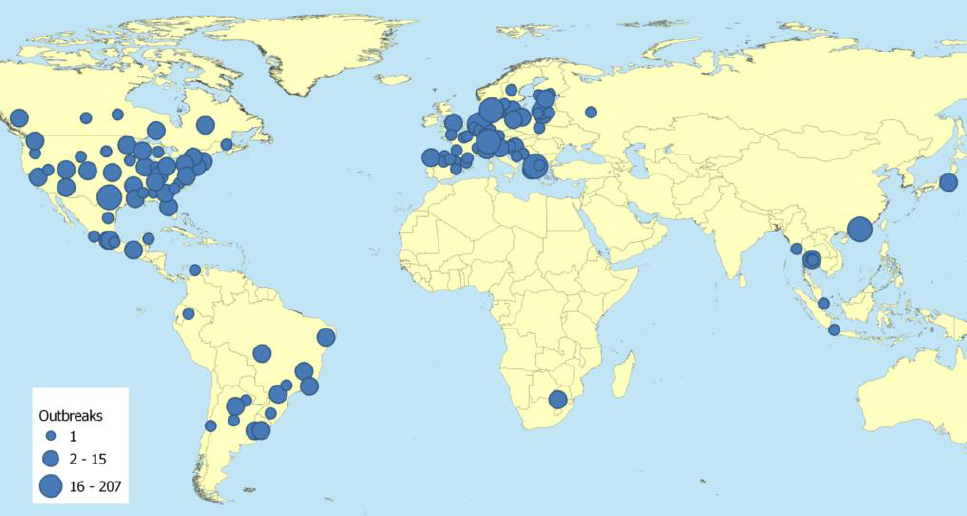
Figure 1. Global distribution of animal infections with SARS-CoV-2. (reprinted with permission from WOAH [3], source: https://www.woah.org/app/uploads/2022/02/sars-cov-2-situation-report-9.pdf, CC BY-NC-ND 4.0(accessed on 19 November 2021).